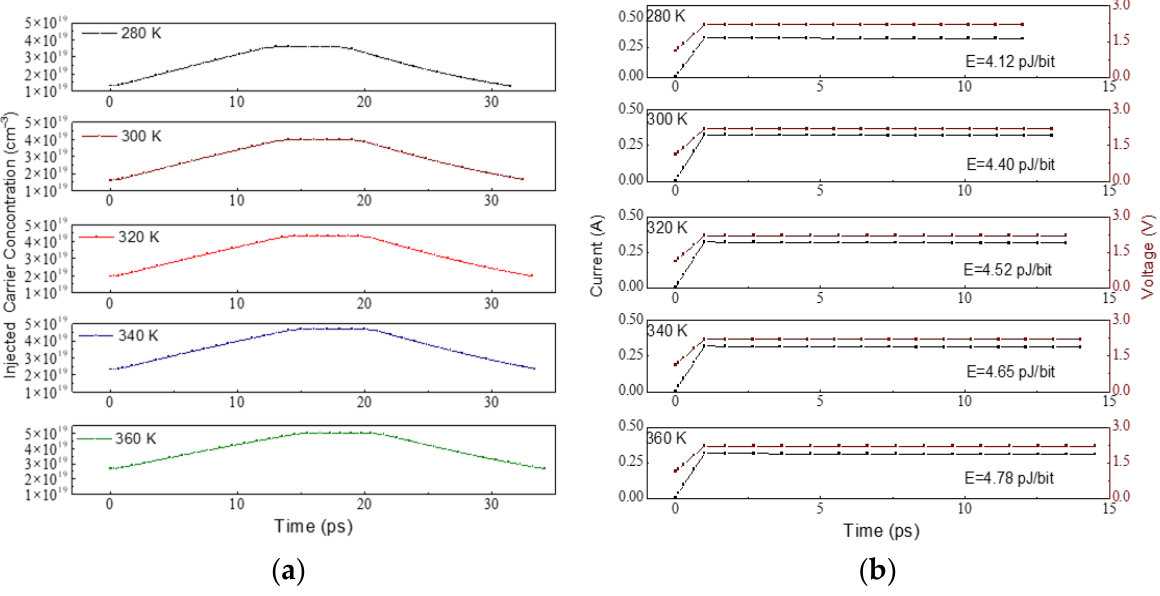
Figure 5. ( a ) The change in carrier concentration with time for different temperatures; ( b ) the VI-t curve for different temperatures.